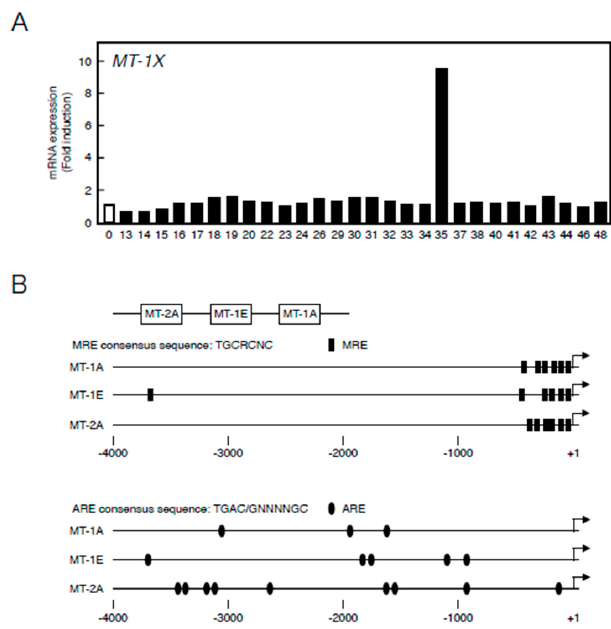
Figure 1. ( A ) Transcriptional induction of MT-1X in vascular endothelial cells after treatment with organoantimony compounds shown in Table 1. Human brain microvascular endothelial cells were incubated with the organoantimony compounds at 10 µM each for 3 h, and the expression of MT-1X mRNA was determined by real-time RT-PCR; ( B ) The map of MRE and ARE regions in the bovine MT promoter.